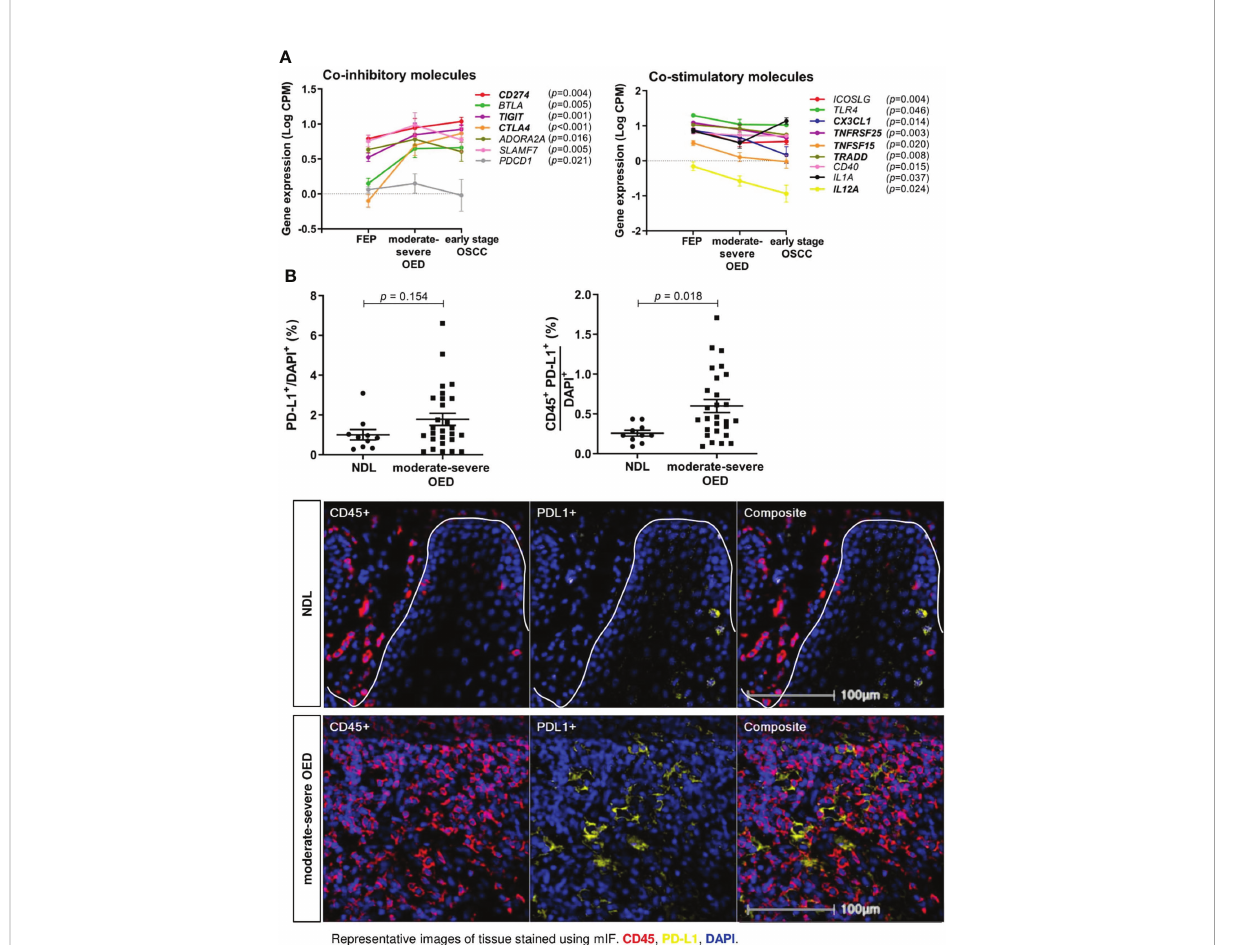
FIGURE 5 The expression of co-stimulatory and co-inhibitory molecules are altered in moderate-severe OED. (A) Upregulation of co-inhibitory immune molecules and downregulation of co-stimulatory immune molecules in moderate-severe OED. Line graph demonstrating the changes of mean expression of immune co-inhibitory and co-stimulatory molecules in FEP, moderate-severe OED and early stage OSCC. The error bars represent the standard error of mean. Three co-inhibitory molecules ( CD274, TIGIT and CTLA4 ) and fi ve co-stimulatory molecules ( TNFRSF25, TRADD, CX3CL1, TNFSF15 and IL12A ) showed a continuous upregulation and downregulation from FEP to moderate-severe OED and early stage OSCC respectively. CD274 and PDCD1 encodes for PD-L1 and PD-1 respectively and is the only ligand-receptor pair found to be consistently upregulated in moderate-severe OED. (B) A high proportion of PD-L1-expressing immune cells detected in moderate-severe OED. A signi fi cant increase of CD45 + PD-L1 + cell number rather than the total PD-L1 + cell number suggested that PD-L1 is expressed in the immune cells and lesser in the epithelial cells of moderate-severe OED. Mean and standard error of mean are indicated for each group of samples. Representative mIF images of DAPI, CD45 and PD-L1 staining at the ROI of NDL and moderate-severe OED. Immune markers in the images were labelled as following: CD45 (red), PD-L1 (yellow), and DAPI